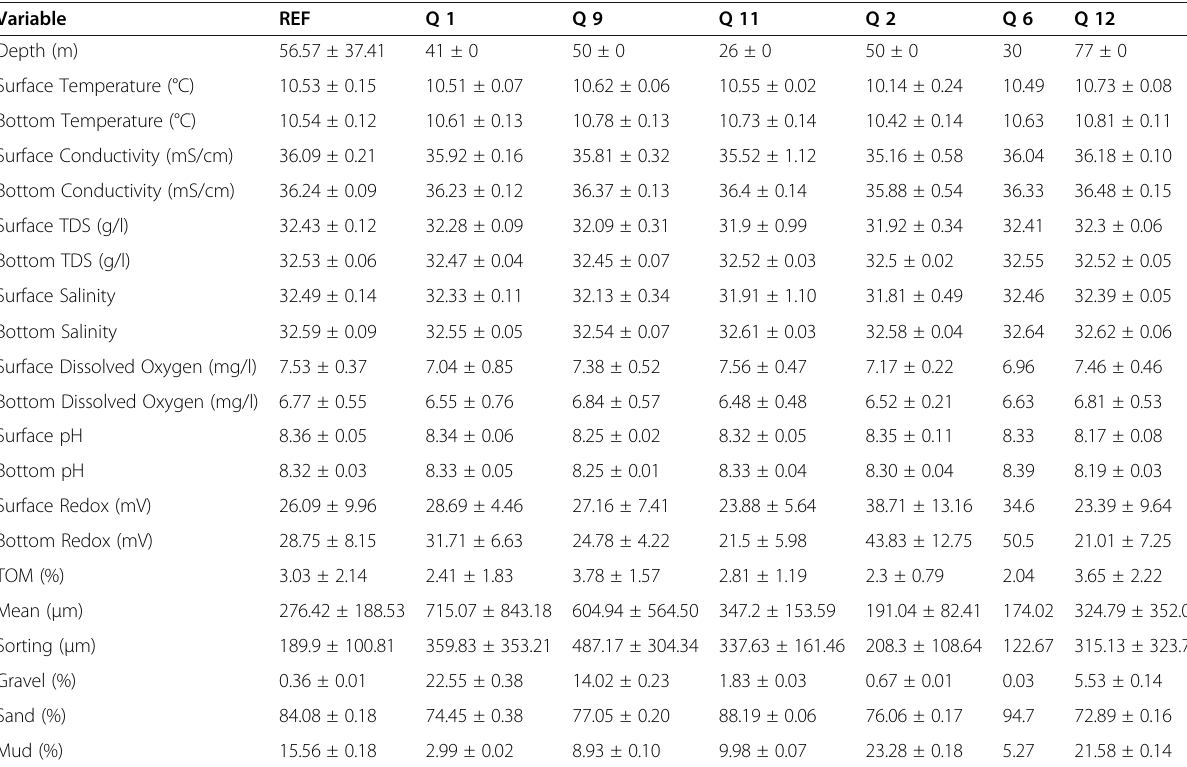
Table 4 Average values (±DE) of environmental variables recorded at surface and deeper strata of each sampling site in Caucahue Channel. REF = references sites; Q1, Q9, Q11 = mussel farms; Q2, Q6, Q12 = salmon